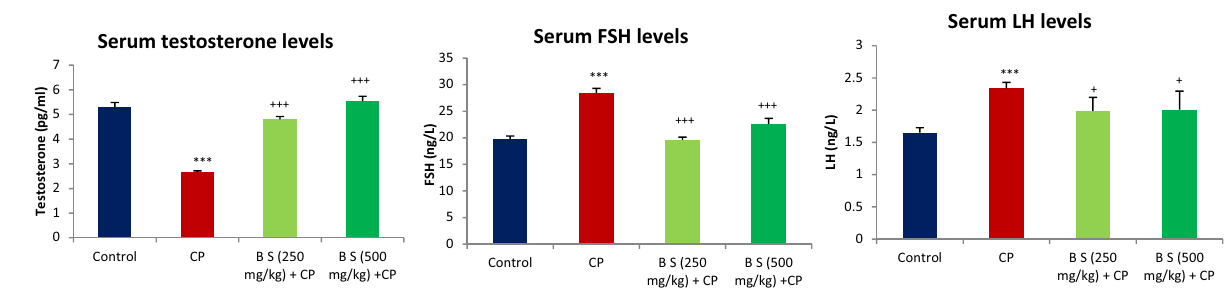
Figure 1. Effect on body weight, testis weight, and relative weight of testis to body weight. All values are mean ± SEM, n = 6. There was no significant change in the weights between the groups. CP = cyclophosphamide (200 mg/kg, i.p), BS Boswellia sacra extract.